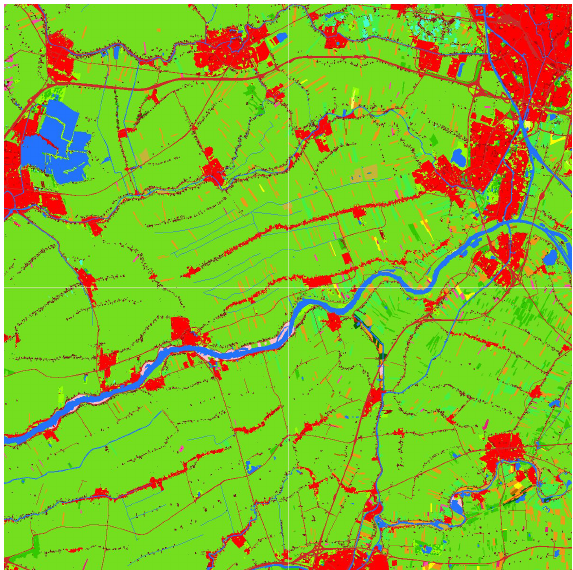
Figure 6. Roughness map for a 30 × 30km area centered at the Cabauw site. Grassland (green) dominates the surface conditions with local values of the roughness length of around 3cm. For the 60–120 ◦ sector of interest, the mesoscale roughness length is around 15cm, characteristic of scattered rough terrain (Verkaik and Holtslag, 2007). This value is also found in the default land use model of WRF, based on the US Geological Survey (USGS, 2011). Figure reprinted from KNMI’s Hydra Project website (KNMI,